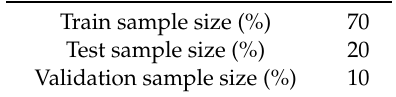
Table 6. Sampling Method